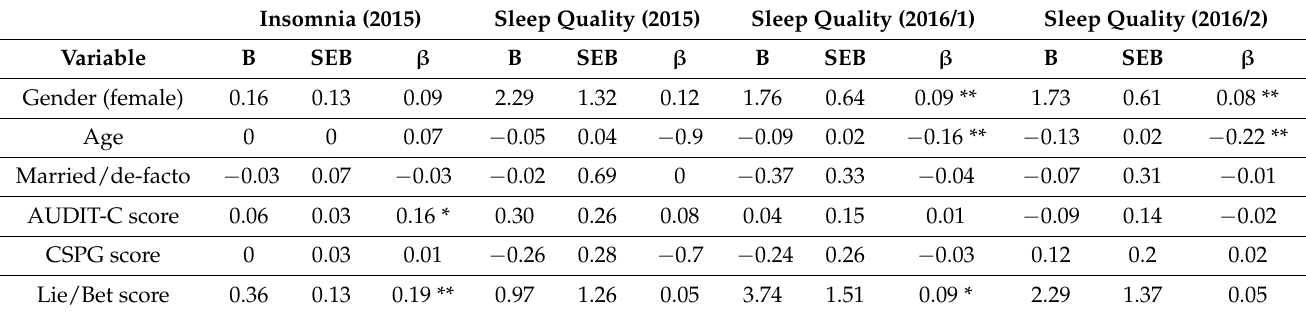
Table 4. Regression analysis for predictors of insomnia score (2015), and subjective sleep quality (2015, 2016; 1 &